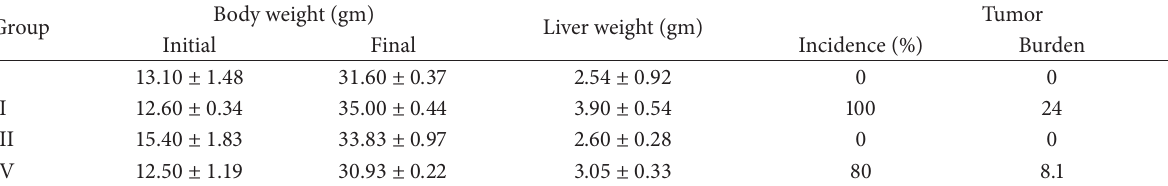
treatmentwithorwithoutACEtreatment. 4